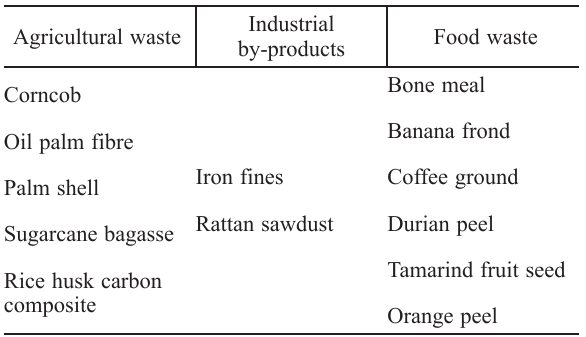
Table 7 – List of potential sources for non-conventional acti- vated carbon adsorbents Agricultural waste